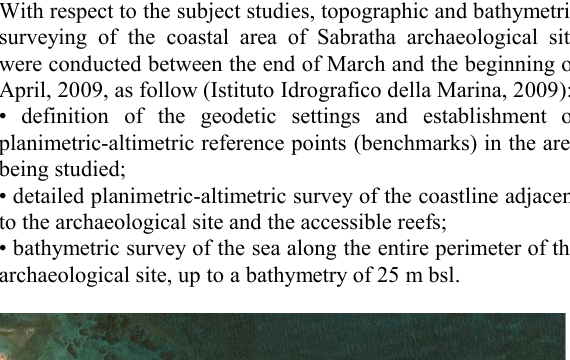
Figure 2. Benchmark